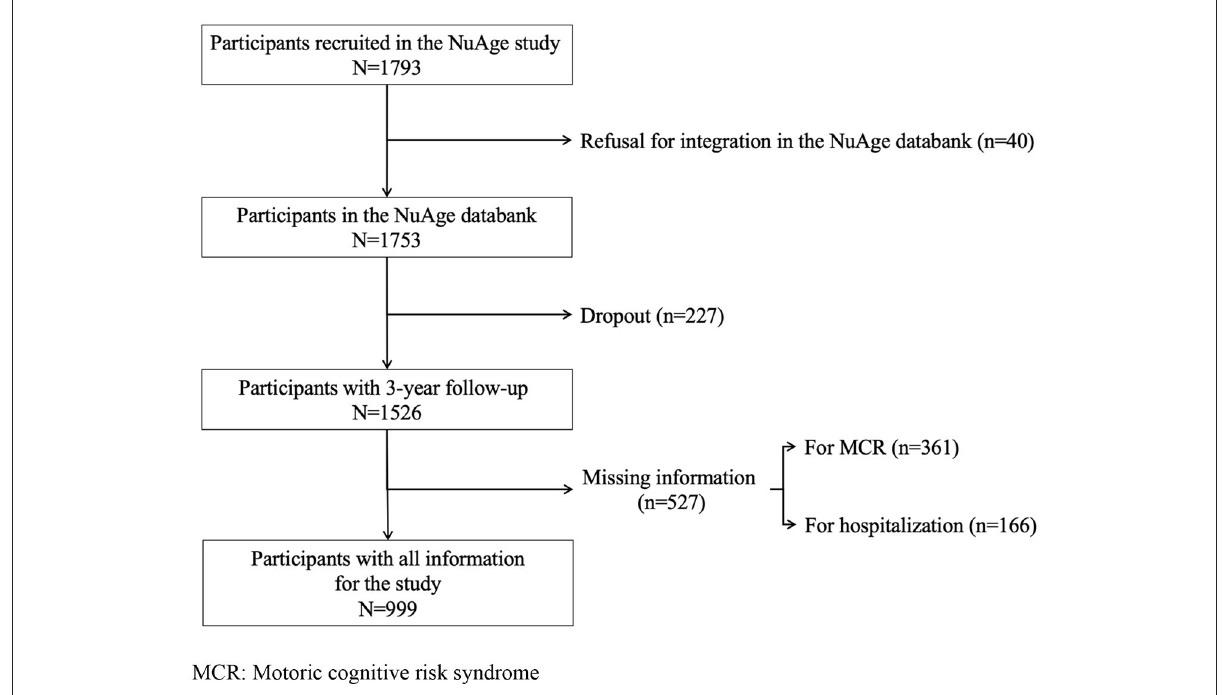
FIGURE1 Flow diagram of the selection of the participants. MCR, Motoric cognitive risk